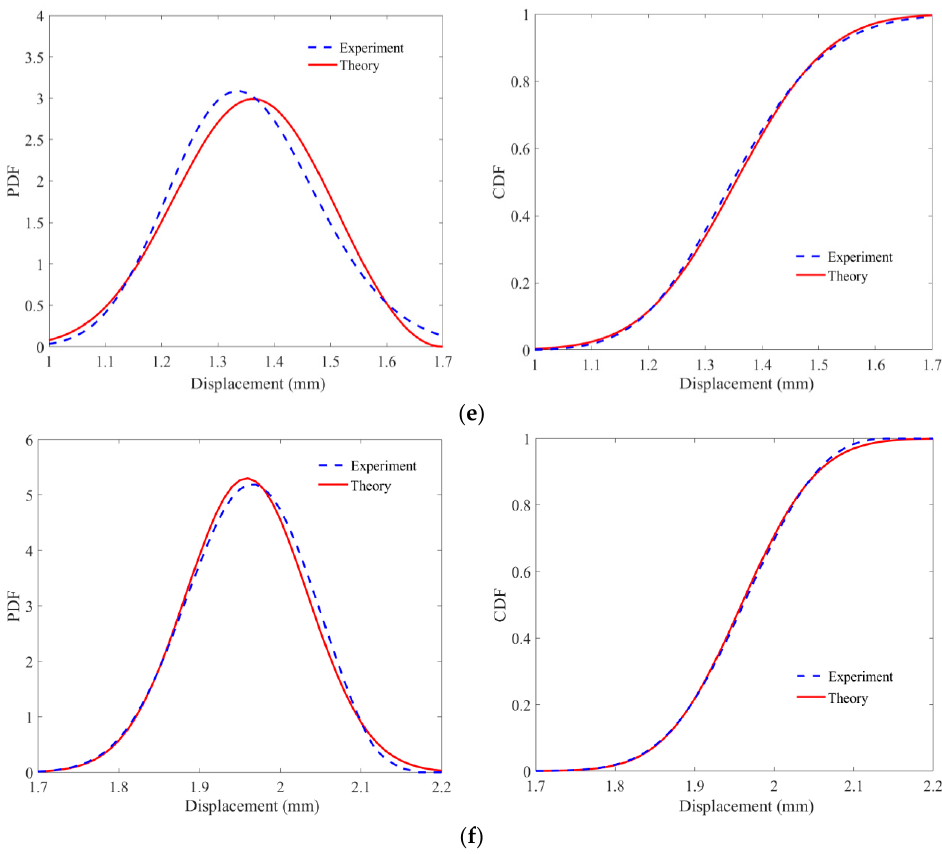
Figure 15. PDF and CDF results of displacement at specific positions: ( a ) Point O, ( b ) Point A1, ( c ) Point A2, ( d ) Point B1, ( e ) Point B2, and ( f ) Point C.